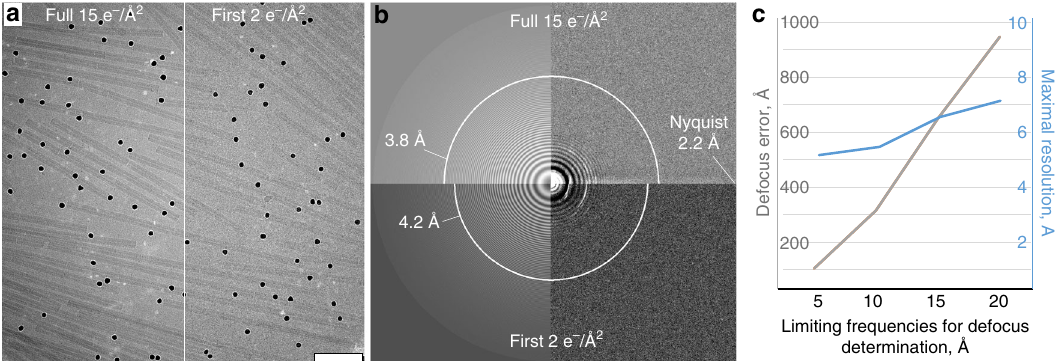
Fig. 2 Improved CTF determination for the Hybrid StA. a A representative micrograph of a 15 e − /Å 2 , 0° tilt image (left) shown together with the fi rst 2 e − /Å 2 of the same image (right). Scale bar: 100 nm. b The detected Thon rings for the two images in ( a ). The white arcs represent the maximum resolution reported by Gctf 38 . c Relationship between the maximum frequencies used for defocus determination ( X -axis) and the precision of defocus estimation ( Y -axis). Grey line: error in defocus determination with limited frequencies compared to the defocus determination with the full range of frequencies; blue line: maximal resolution up to which the estimated CTF fi ts with the data, as reported by Gctf 38